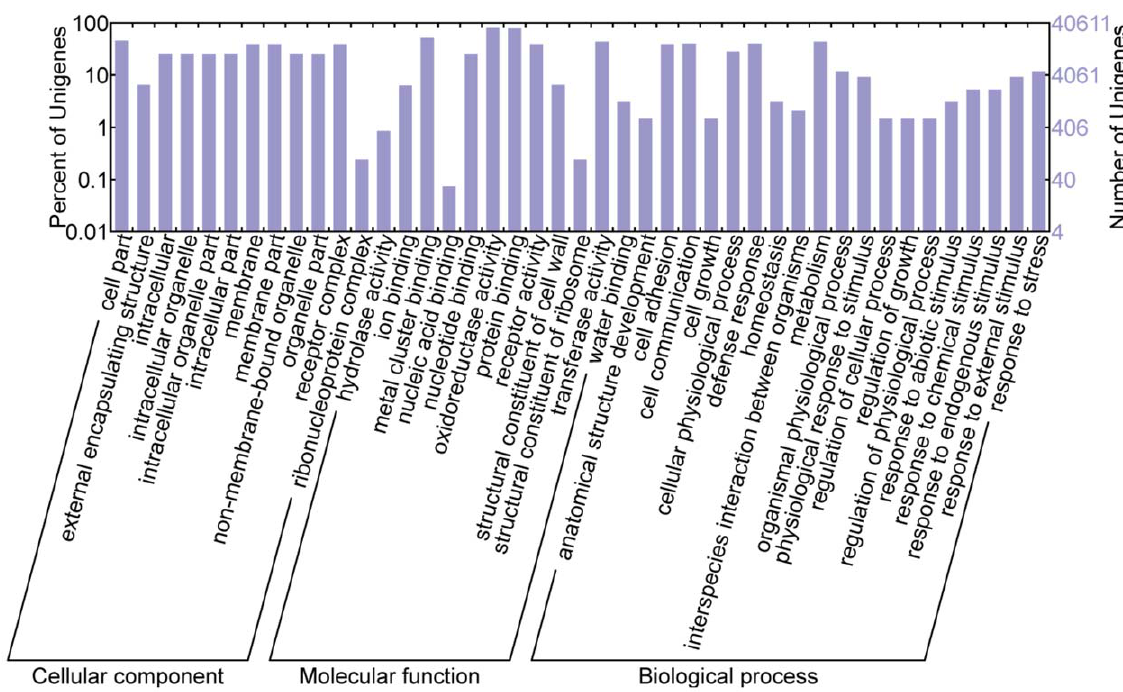
Figure 2. Distribution of unigenes based on the Gene Ontology (GO) functional categories.